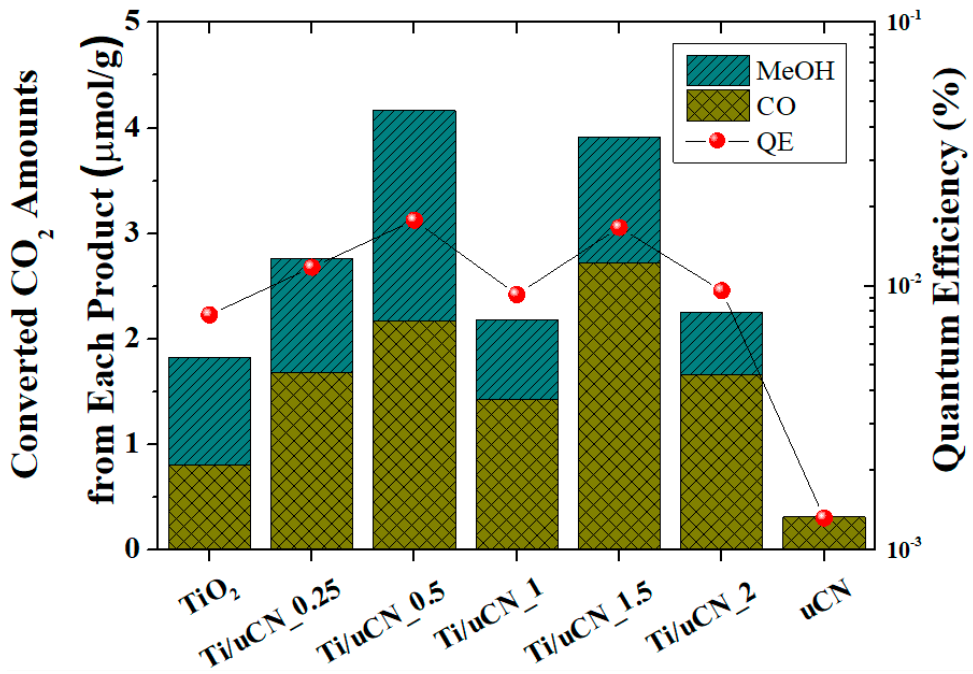
Figure 6. Converted CO 2 amounts and quantum efficiency (QE) of each sample.